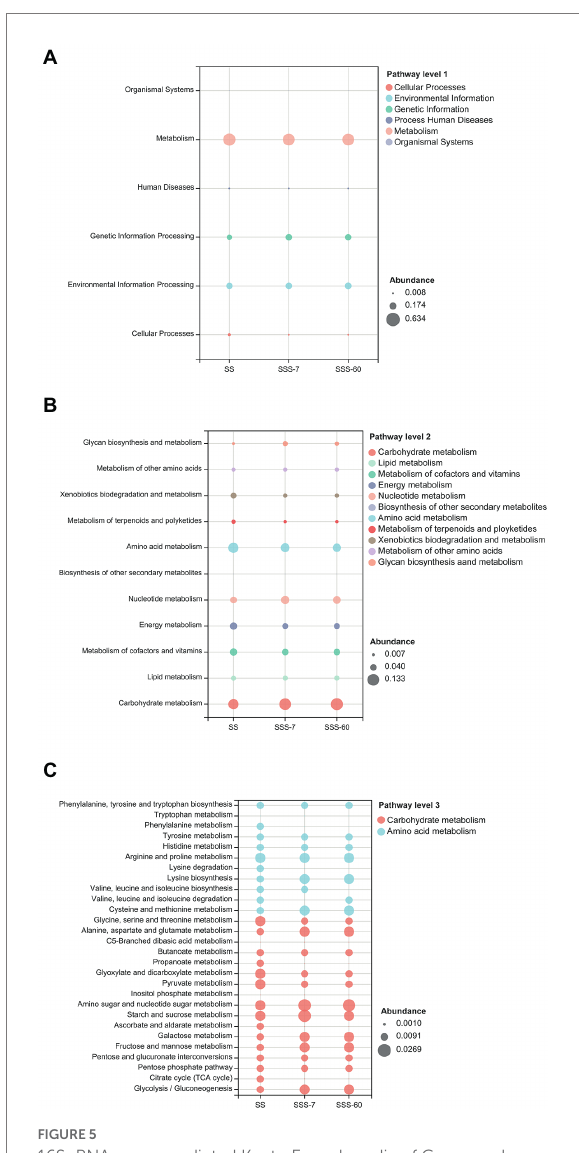
FIGURE 5 16S rRNA gene-predicted Kyoto Encyclopedia of Genes and Genomes (KEGG) function profiles at pathway level 1 (A) , pathway level 2 (B) and pathway level 3 (C) . SS, high-moisture sweet sorghum; SSS, SS